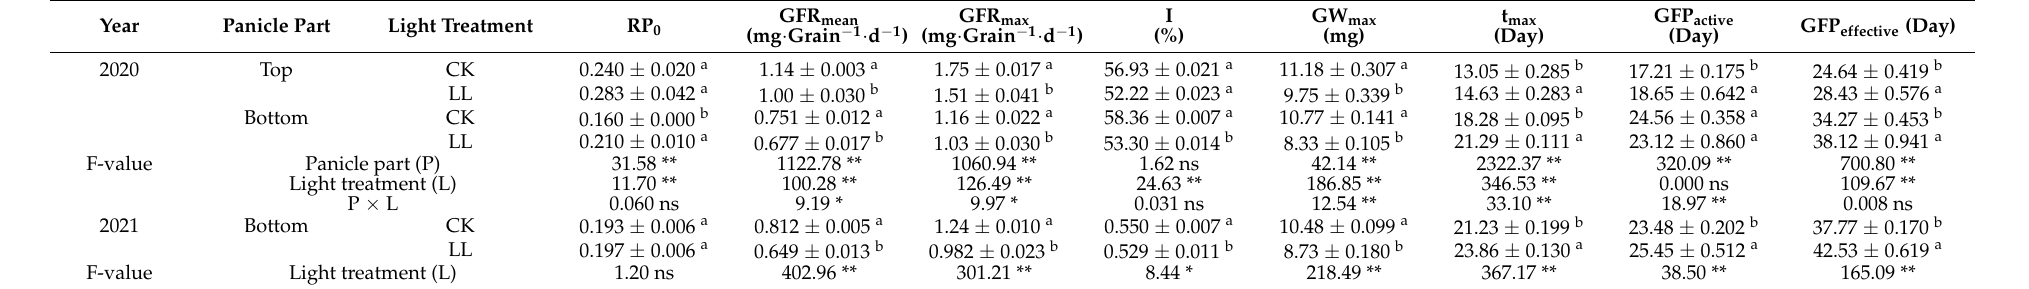
Table 3. Grain filling characteristics at different panicle parts.